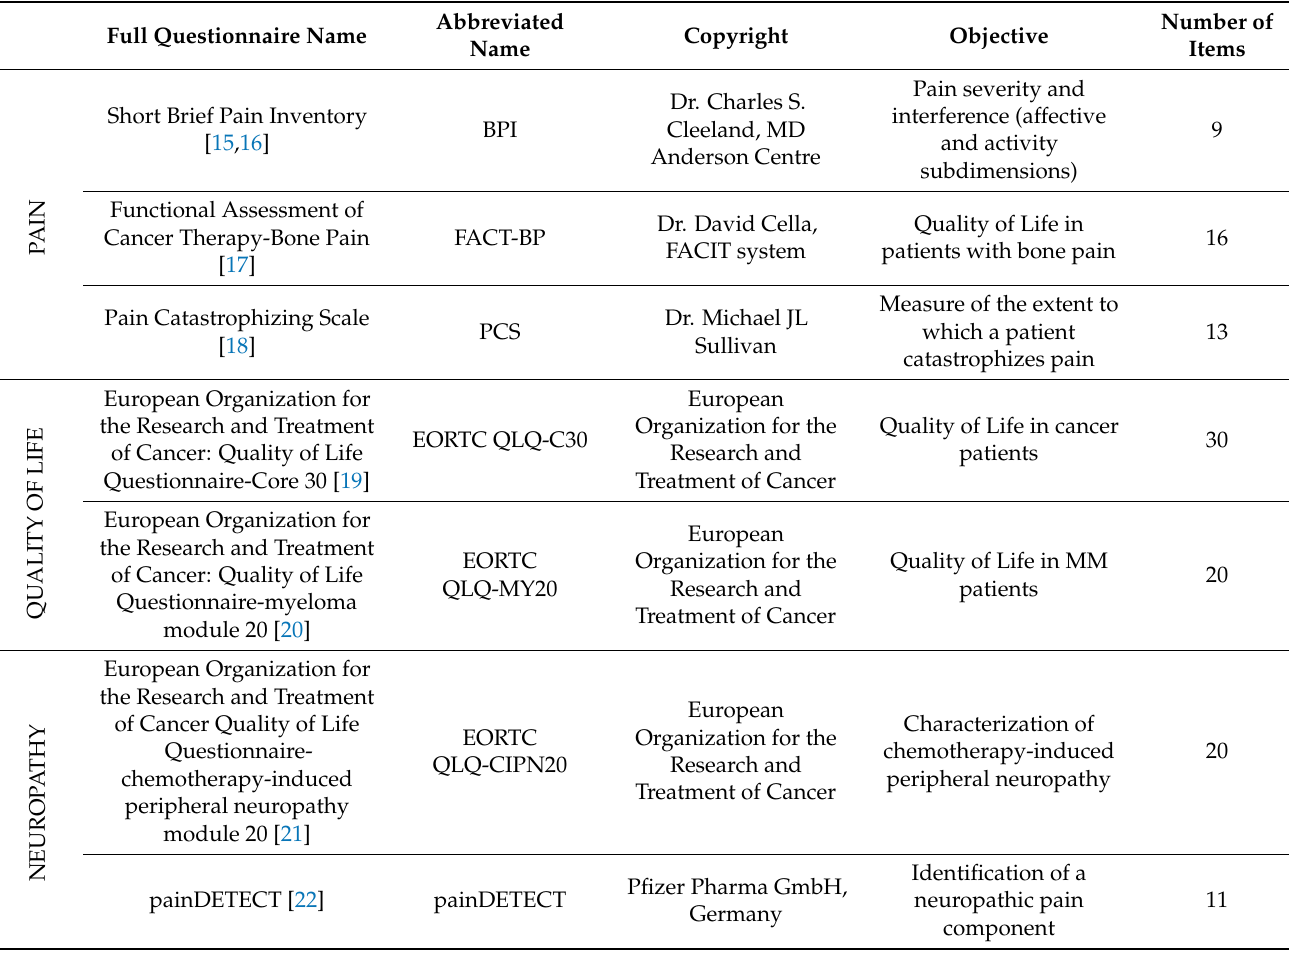
Table 1. Patients recruited in the Bone Pain in Multiple Myeloma Study are provided with a booklet containing seven validated, standardized questionnaires assessing pain, quality of life and catastrophizing. MM = Multiple